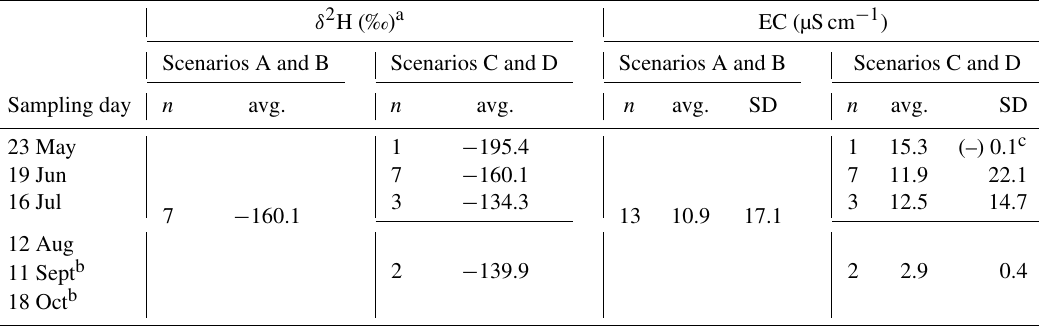
Table 4. Isotopic composition ( δ 2 H) and EC of the snowmelt end-member used in the two- and three-component mixing model for the four scenarios for 2013 data. Abbreviations are used as in Table 2.